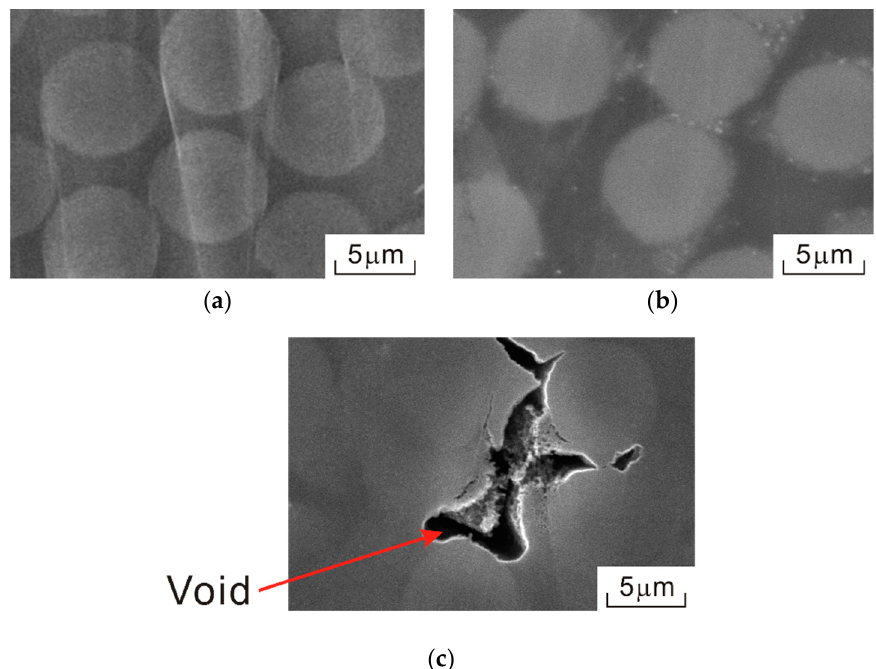
Figure 14. SEM images of the cross ‐ sections of the welded zone of ( a ) As ‐ received, ( b ) CNT10 and ( c ) CNT60.